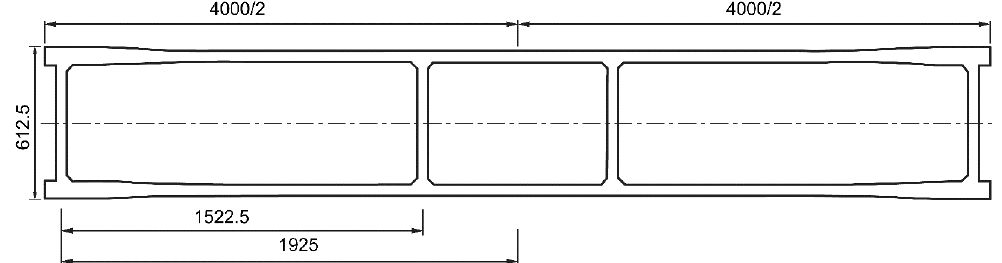
Figure 1. Cross-sectional arrangement of the test beam (mm) ( a ) Test beam midspan section size, and ( b ) Cross-sectional arrangement of the test beam support points.